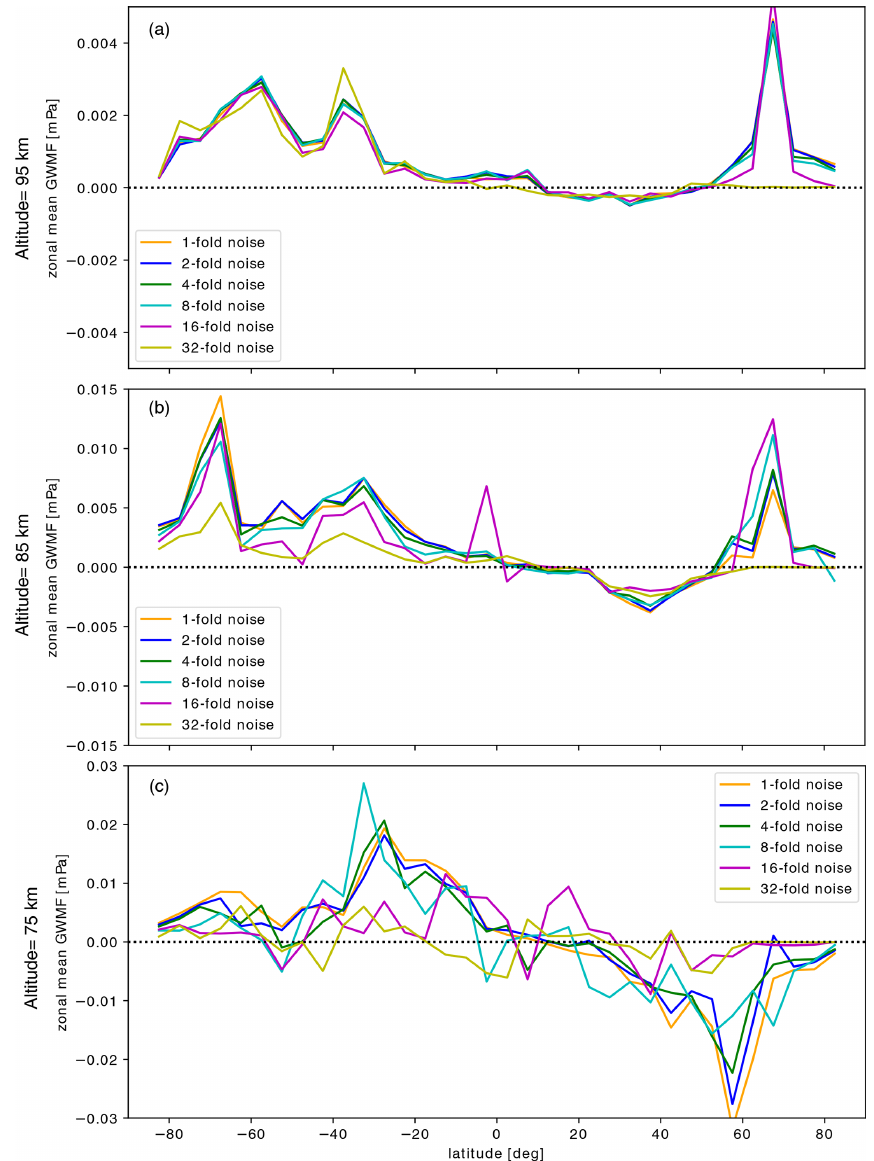
Figure 17. Line plots of the zonal components of zonal mean GW momentum flux in 5 ◦ latitude bins from S3D analysis on retrieved temperature residuals with estimation of different noise levels of 1 (orange line), 2 (blue line), 4 (green line), 8 (cyan line), 16 (magenta line), and 32 (yellow line) at an altitude of 75km (a) , 85km (b) , and 95km (c) . A four-track case is applied for this